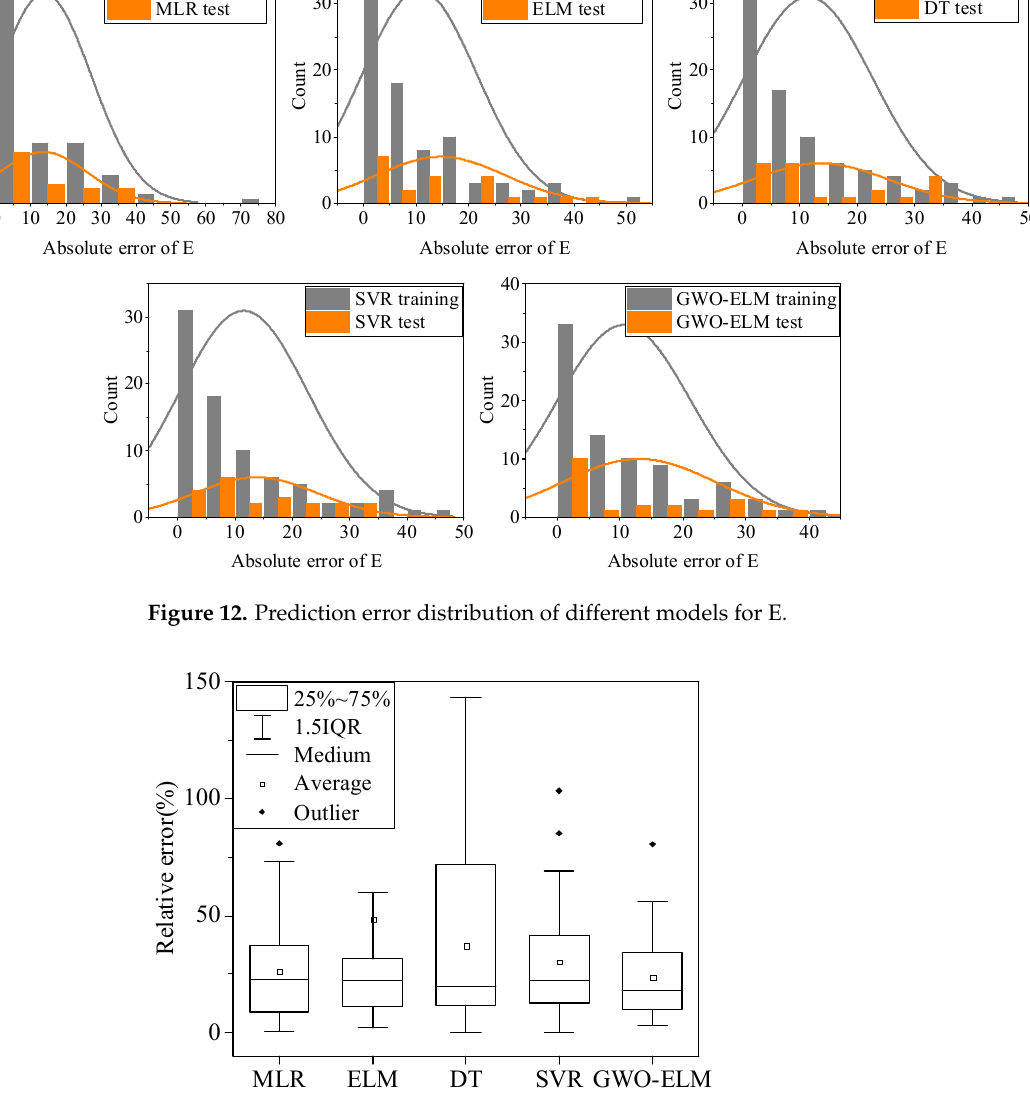
Figure 13. Box plot of relative error for E. Table 3. Evaluation index of different models for E.